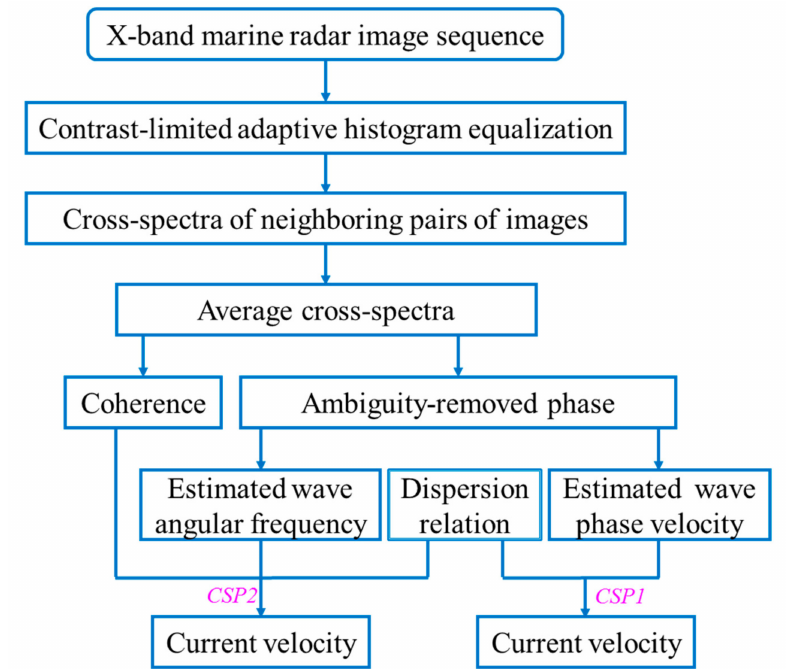
Figure 1. The flowchart of the method used to retrieve sea surface current from an X-band marine radar image